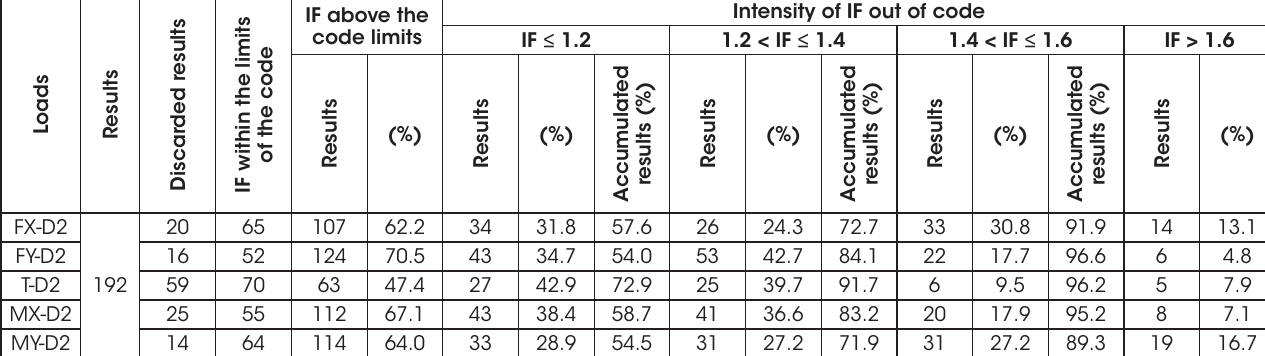
Results for distance D2